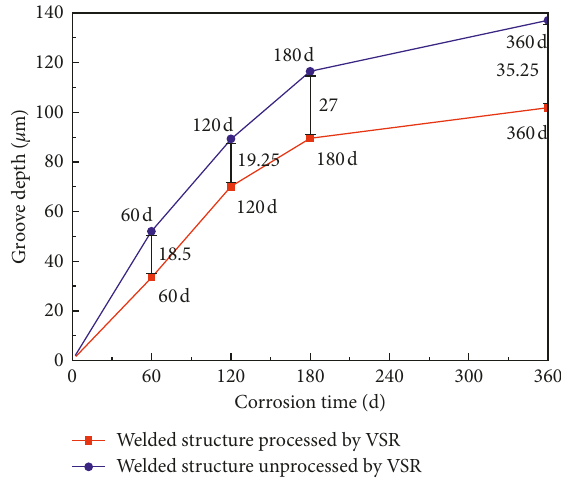
Figure 6: Changes of corrosion groove